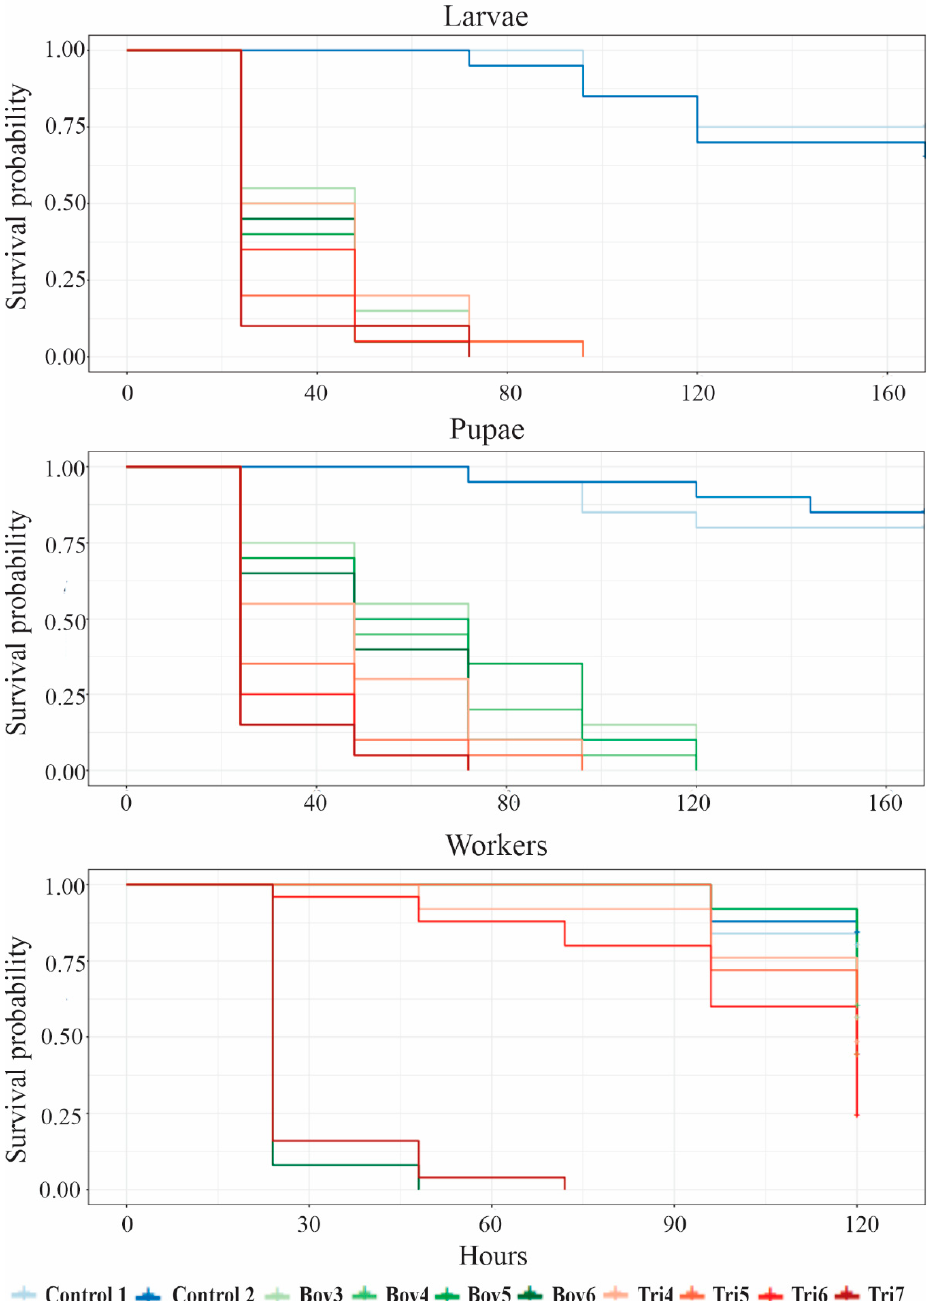
Figure 2. Survival curve of Atta sexdens rubropilosa Forel 1908 (Hymenoptera: Formicidae) larvae, pupae and workers immersed in suspensions of Beauveria bassiana and Trichoderma harzianum .